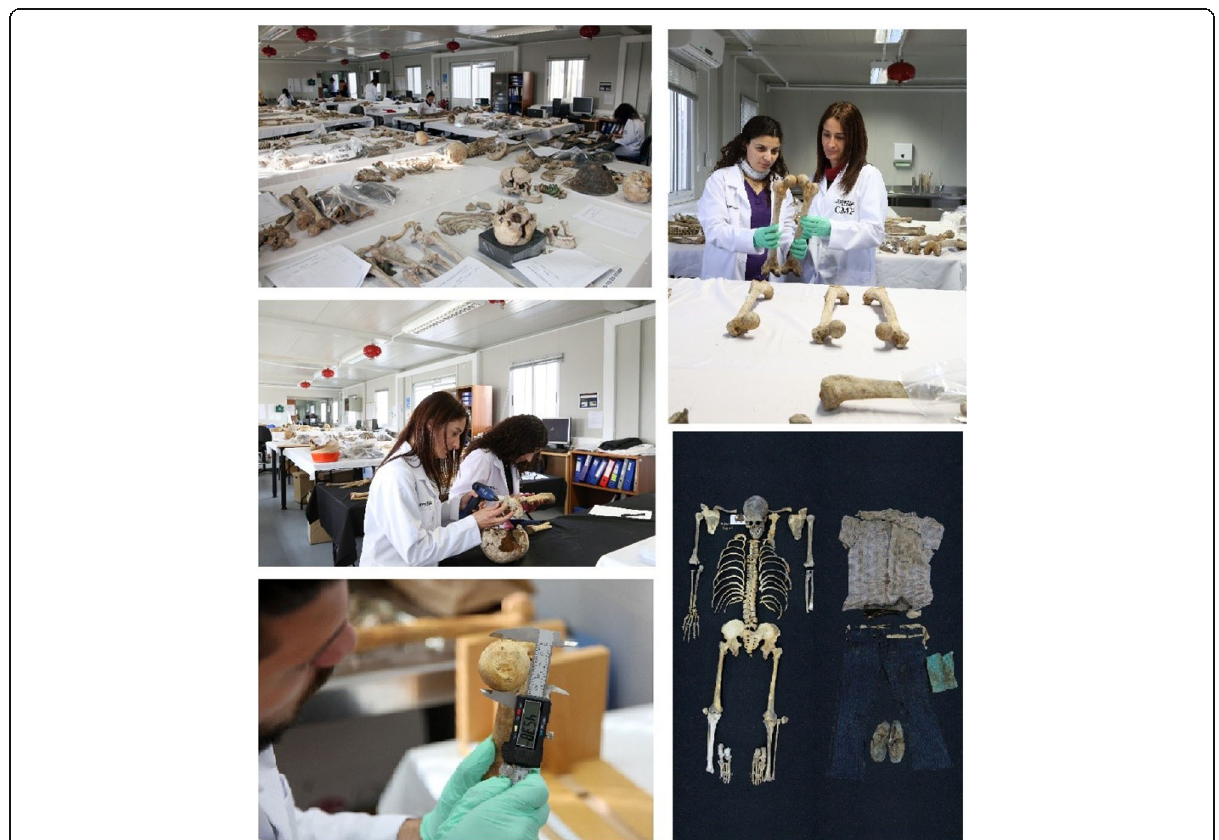
Fig. 4 The anthropological analyses conducted at CAL, resulting in the positioning of a skeleton in an anatomical position with associated